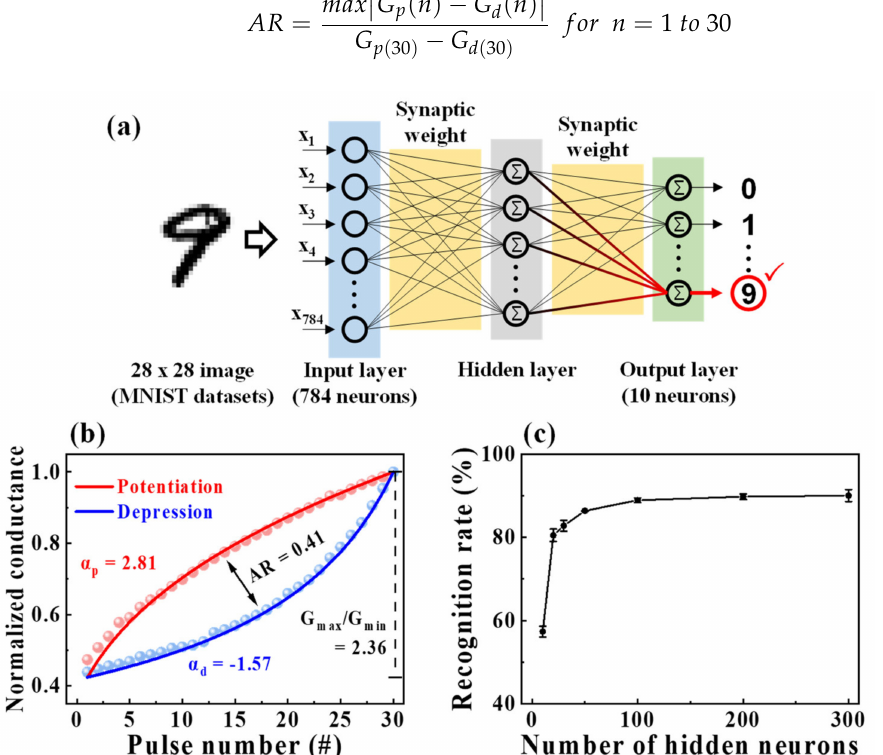
Figure 8. ( a ) Schematics of a three-layer fully connected artificial neural network (ANN) comprising the input, hidden, and output layers for handwritten Modified National Institute of Standards and Technology (MNIST) recognition. ( b ) Nonlinearity analysis on normalized potentiation and depression (G/G max ). ( c ) Simulated recognition rate with different numbers of hidden neurons. The error bar indicates the standard